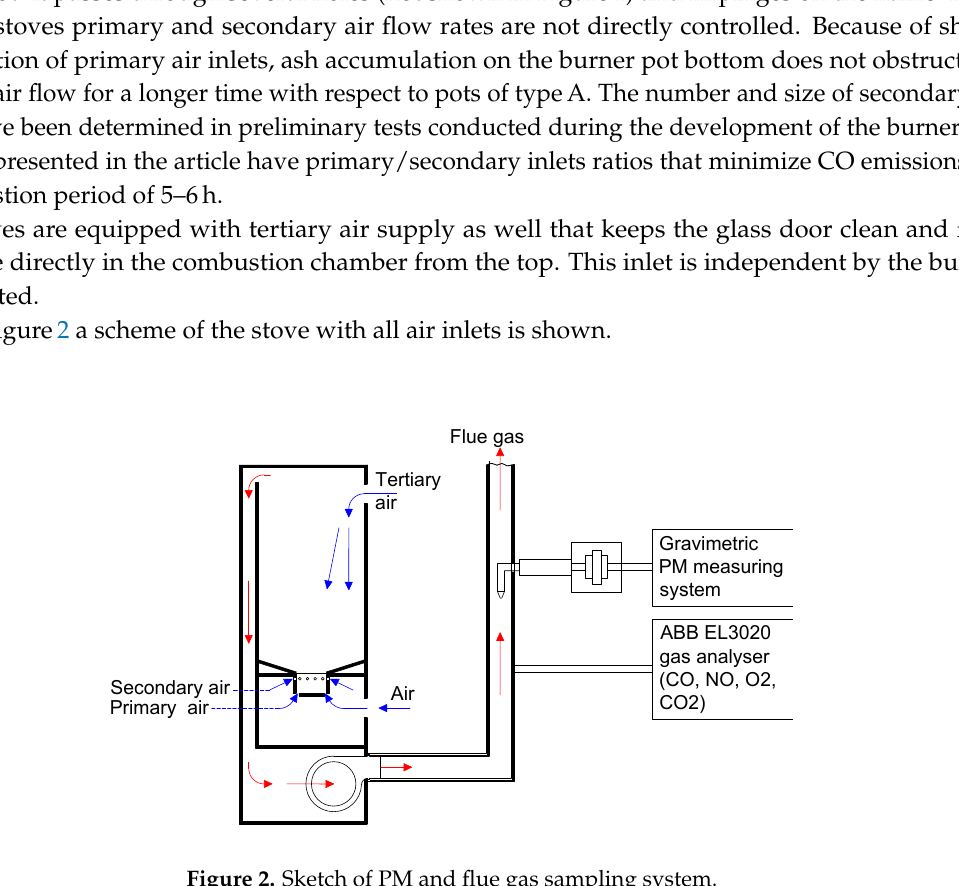
Figure 2. Sketch of PM and flue gas sampling system.